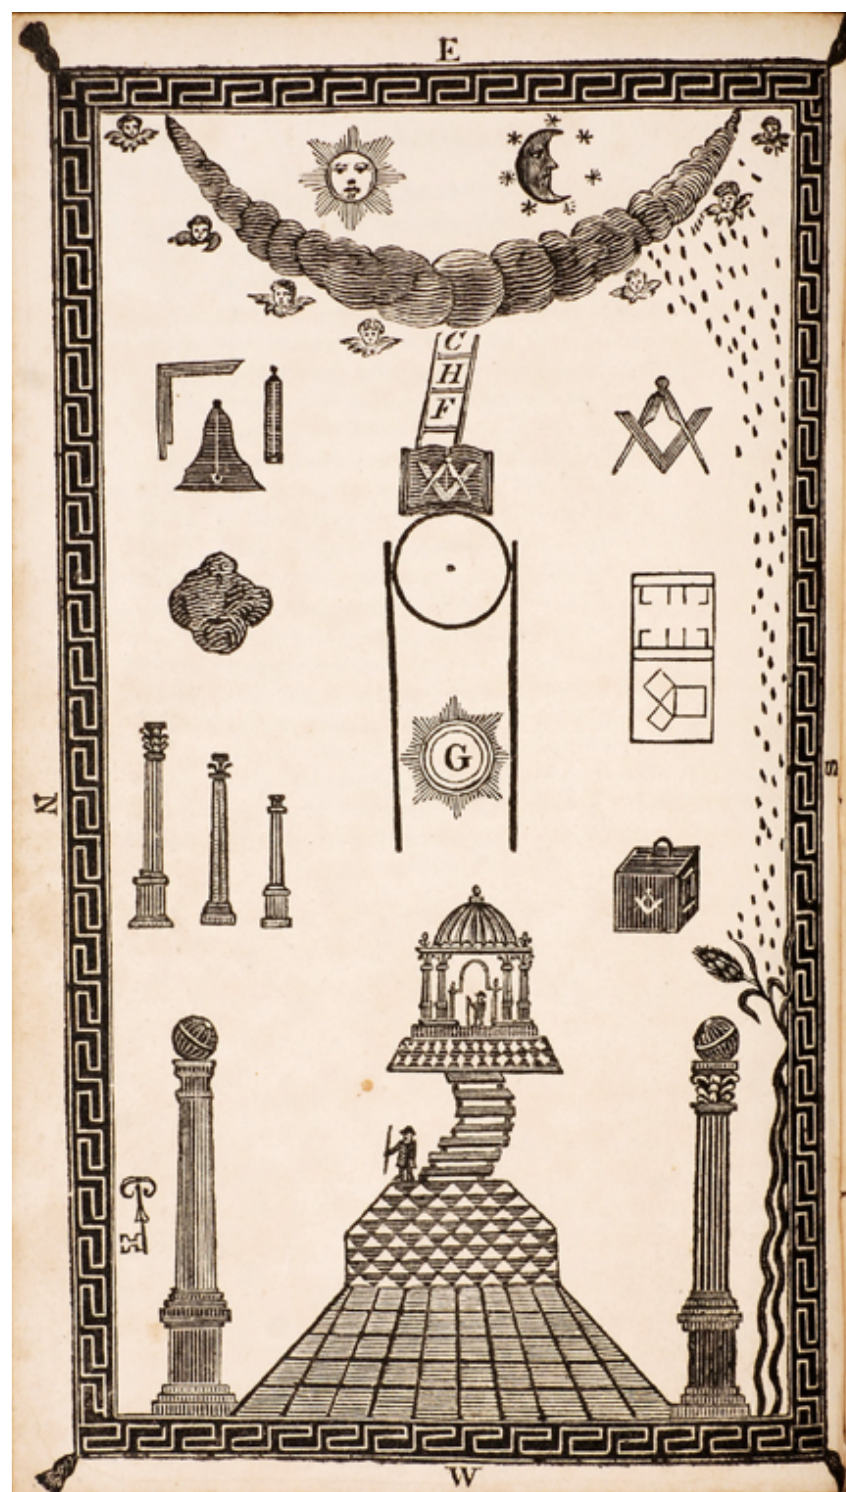
Fig. 10. Masonic motifs from William Preston, Illustrations of Masonry , 12th edition (1812). Image courtesy of Peter Harrington.